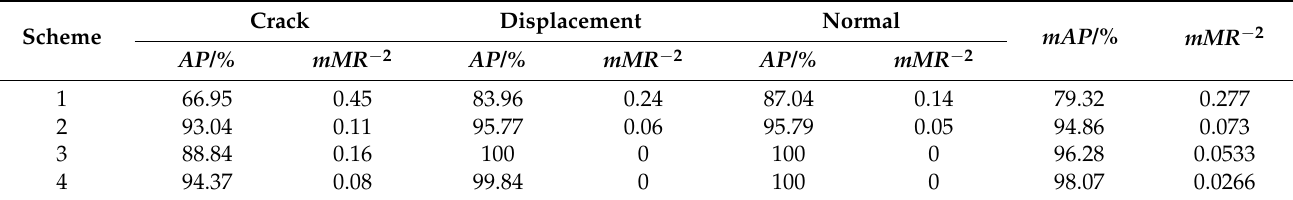
Table 2. Comparison of detection effects of various improvement schemes.